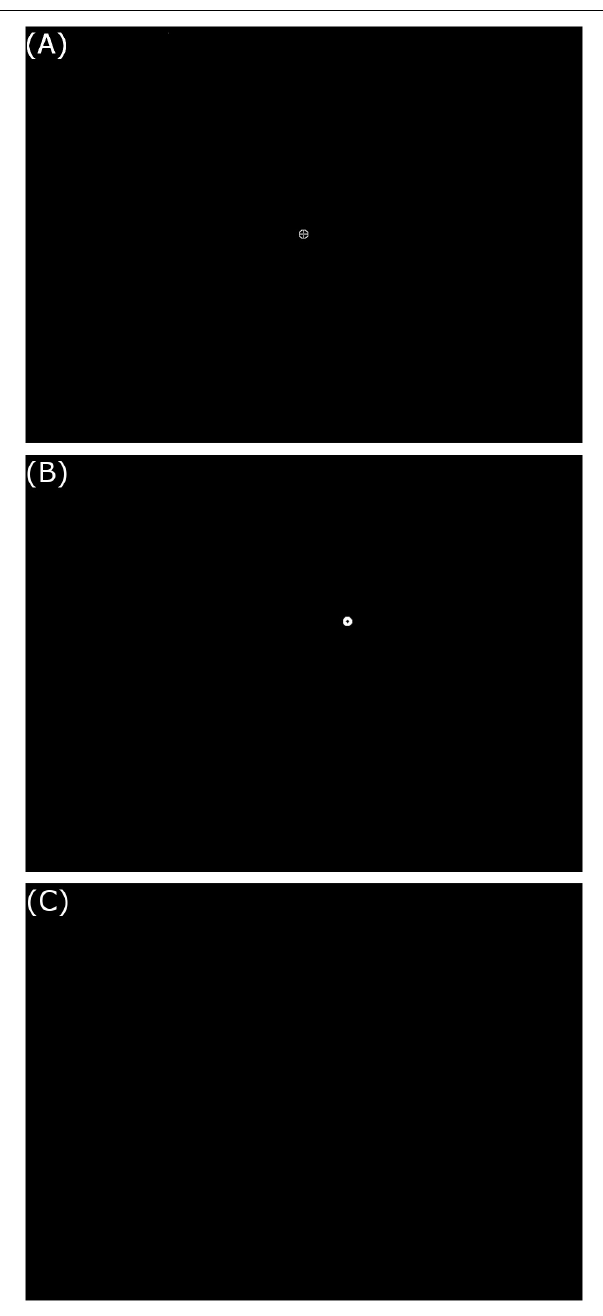
FIGURE 3 | Example reflexive testing trial display sequence. (A) Central fixation target, (B) 20 ◦ northeast target, and (C) blank reset screen. All images presented in 800 × 600 resolution on screen.